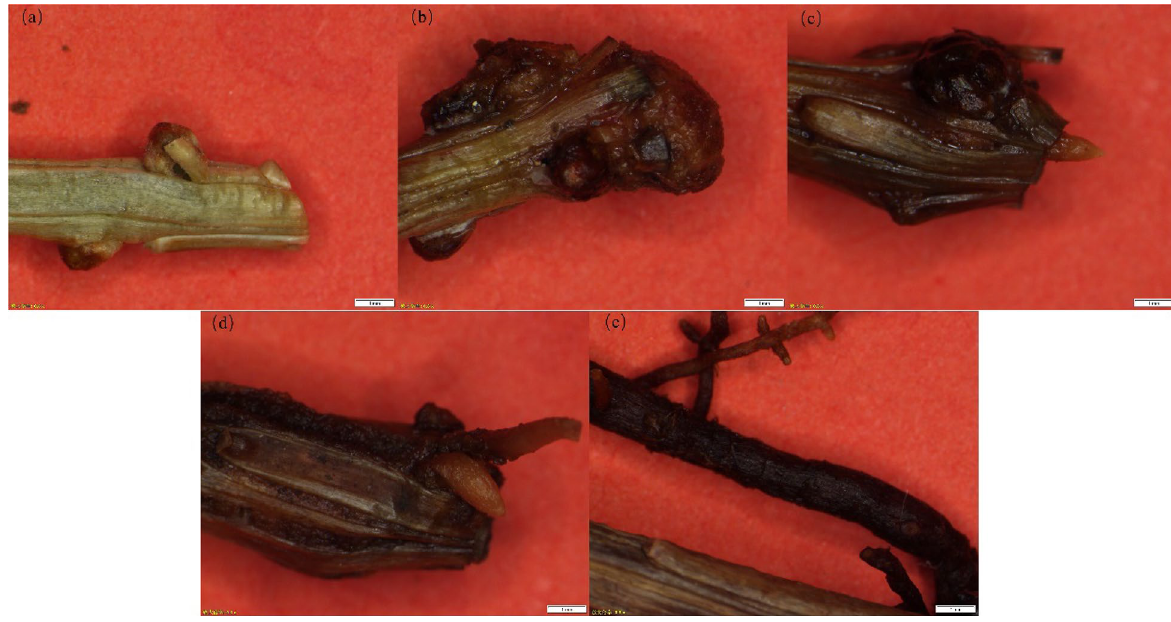
Figure 8. Rooting initiation stage ( a ), callus formation stage ( b ), adventitious root induction stage ( c , d ) and adventitious root growth stage ( e